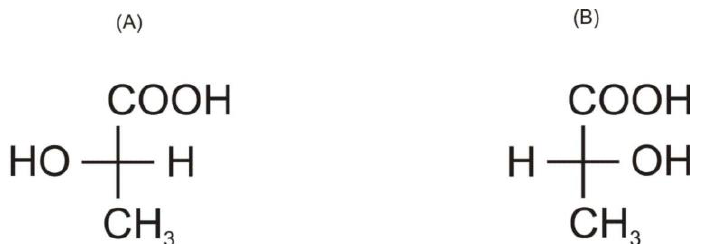
Figure 2. Three-dimensional structure of optical L-lactic acid ( A ) and D-lactic acid ( B ) (Adapted from Pohanka (2020)